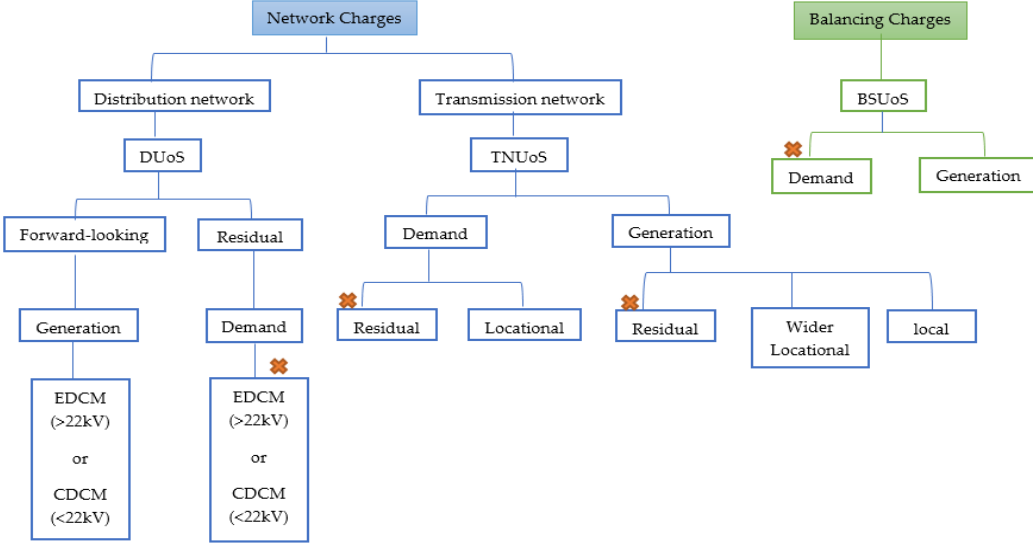
Figure 2. Network and Balancing system charges in the UK’s electricity system, adopted from [68]. (x) means removed for ES per new legislations.